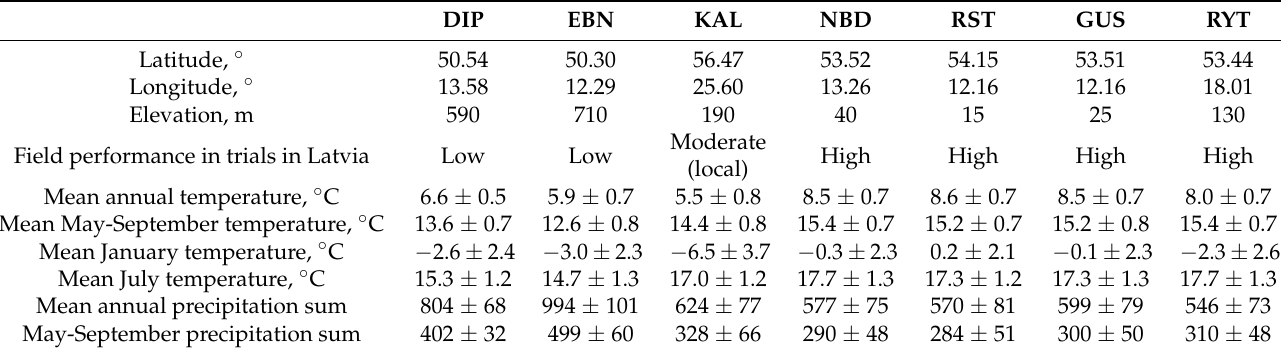
Table 2. Location and general climatic description (means ± standard deviation for the period 1945–1974) of the studied provenances of Scots